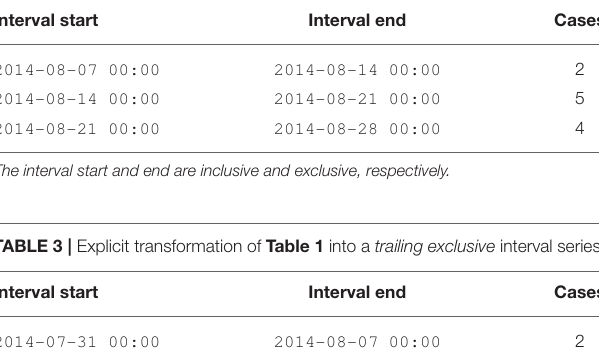
TABLE 2 | Explicit transformation of Table 1 into a leading interval series. Interval start Interval end Cases